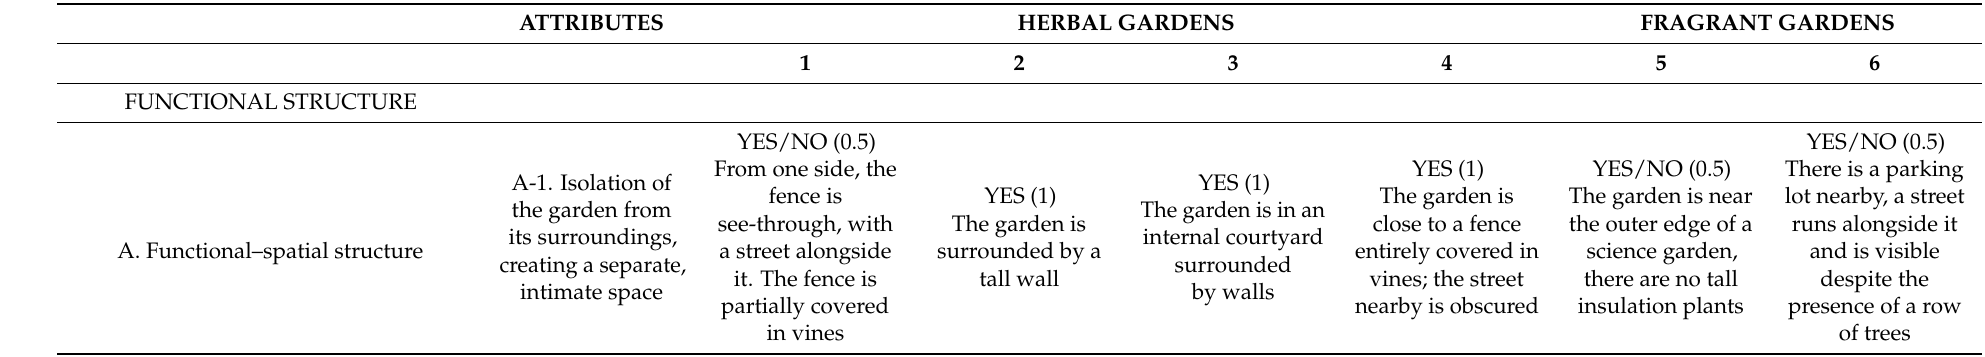
Table 6. Analysis of the therapeutic properties of herbal gardens with sensory features, part 2—other